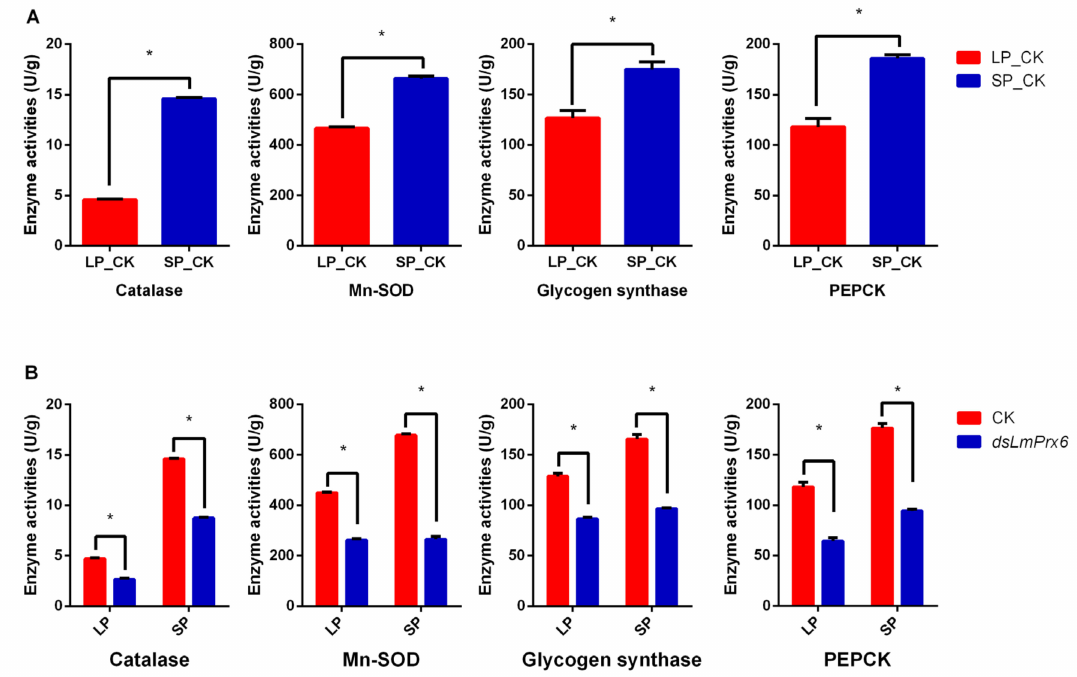
Figure 7. ( A ), Catalase, Mn-SOD, glycogen synthase, and PEPCK activities in the whole body of adult females under long and short photoperiods. ( B ), The comparison of catalase, Mn-SOD, glycogen synthase, and PEPCK activities detected in the whole body of adult females with and without injection of dsLmPrx6 under SP and LP. All results were expressed as means ± standard error (SE) of three replicates. * Indicates probability level of p < 0.05 by Student’s t